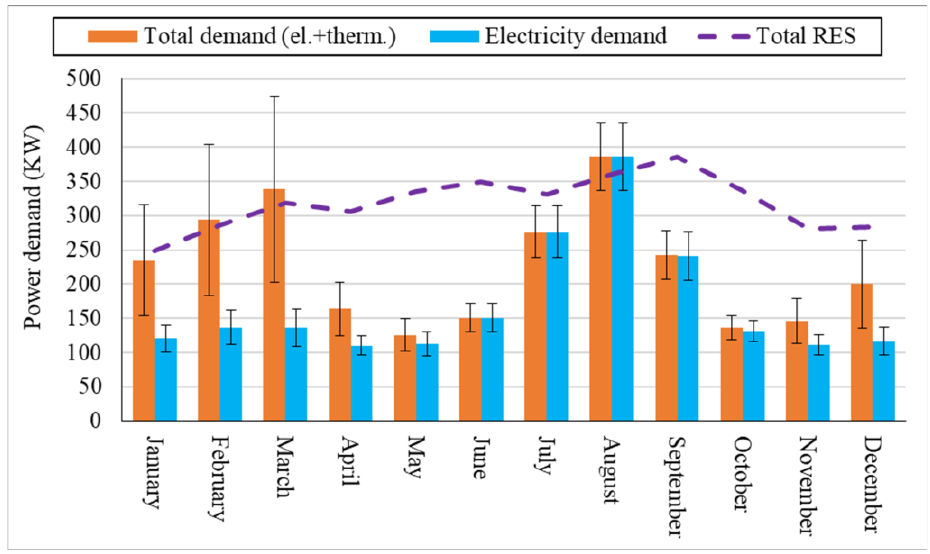
Figure 4. The average monthly demand for electrical and thermal power for Anafi along with the total power production of RES.